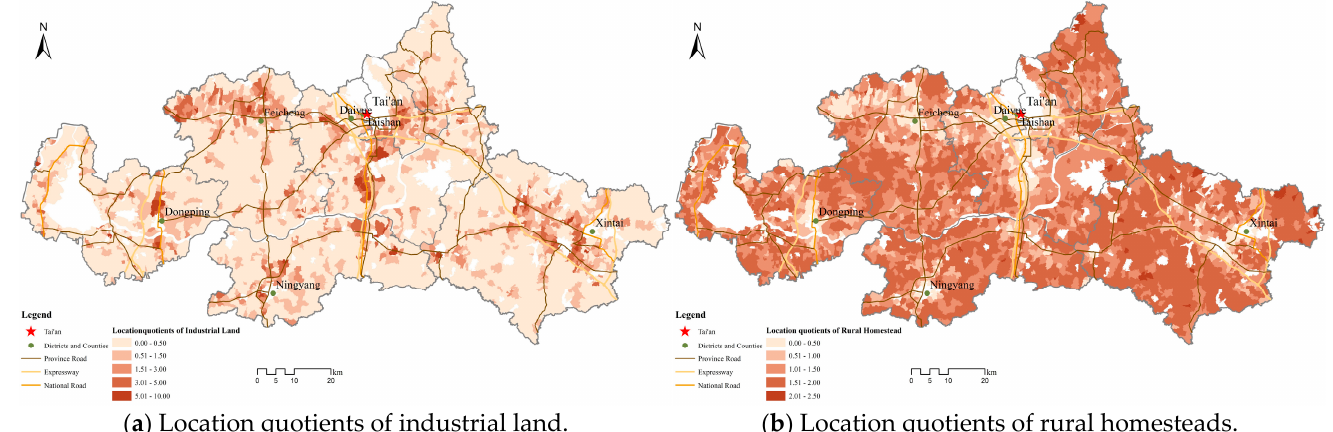
Figure 3. Location quotients of different types of rural construction land.